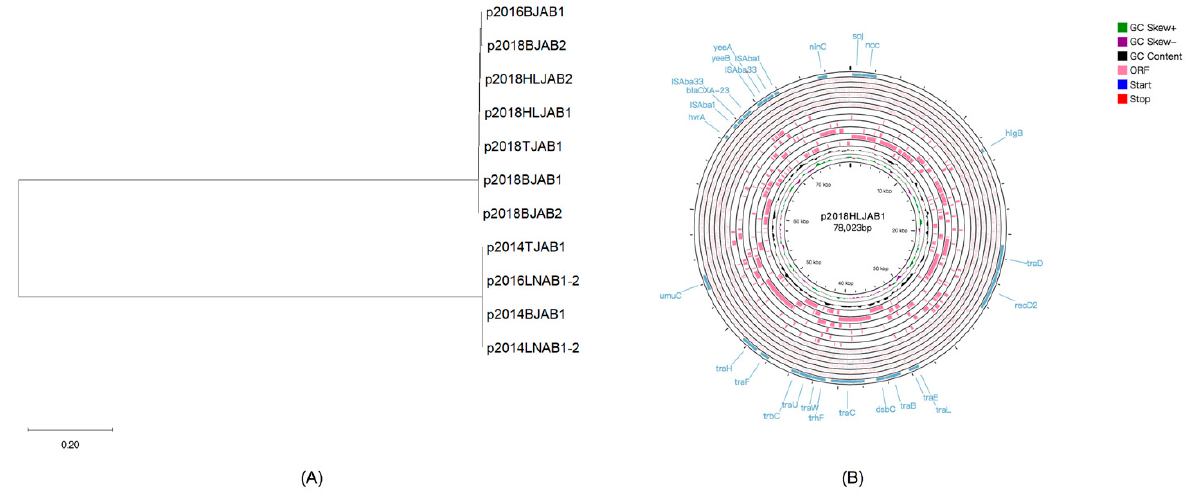
Figure 5. Characteristics of CO plasmids. ( A ) Rooted phylogenetic tree of CO plasmids. ( B ) Circular map of the type II plasmid, p2018HLJAB1. The inner circles represented the GC skew and GC content information. The outer circles represented the open reading frames and the start/ stop codons. Regions related to antibiotic resistance and conjugation were marked in blue.